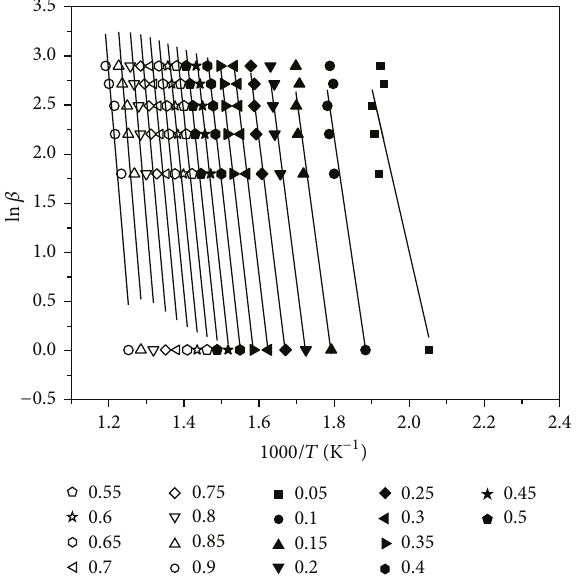
Figure 6: FWO plots of lignite coal pyrolysis at different values of conversion.